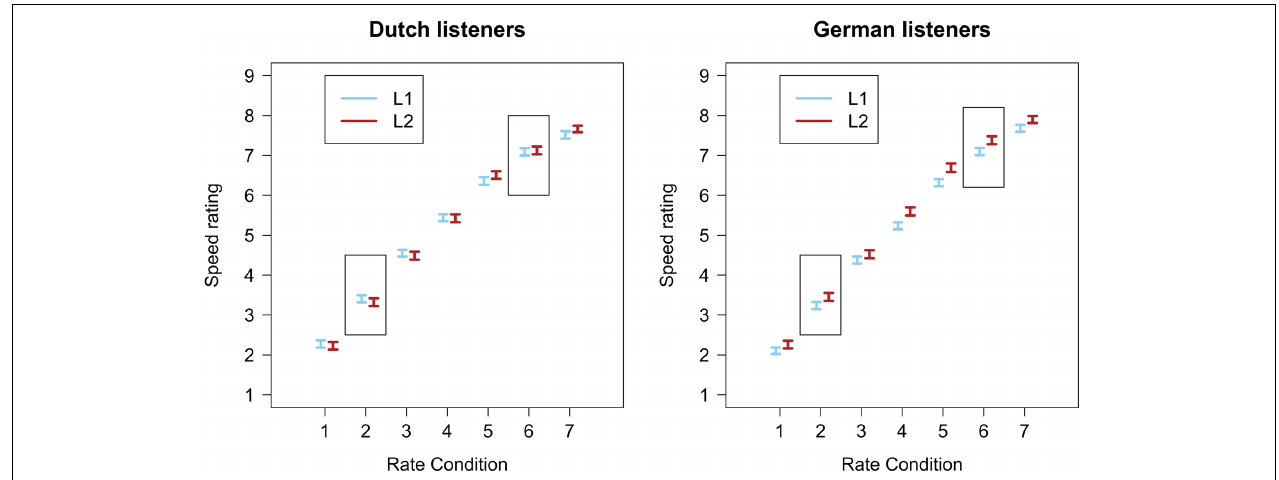
FIGURE 5 | Average speed ratings of Experiment 3 (error bars show standard errors). (Left) Data from the Dutch listener group; (Right) data from the German listener group. The rectangles indicate the two rate conditions used in Experiments 1 and 2.